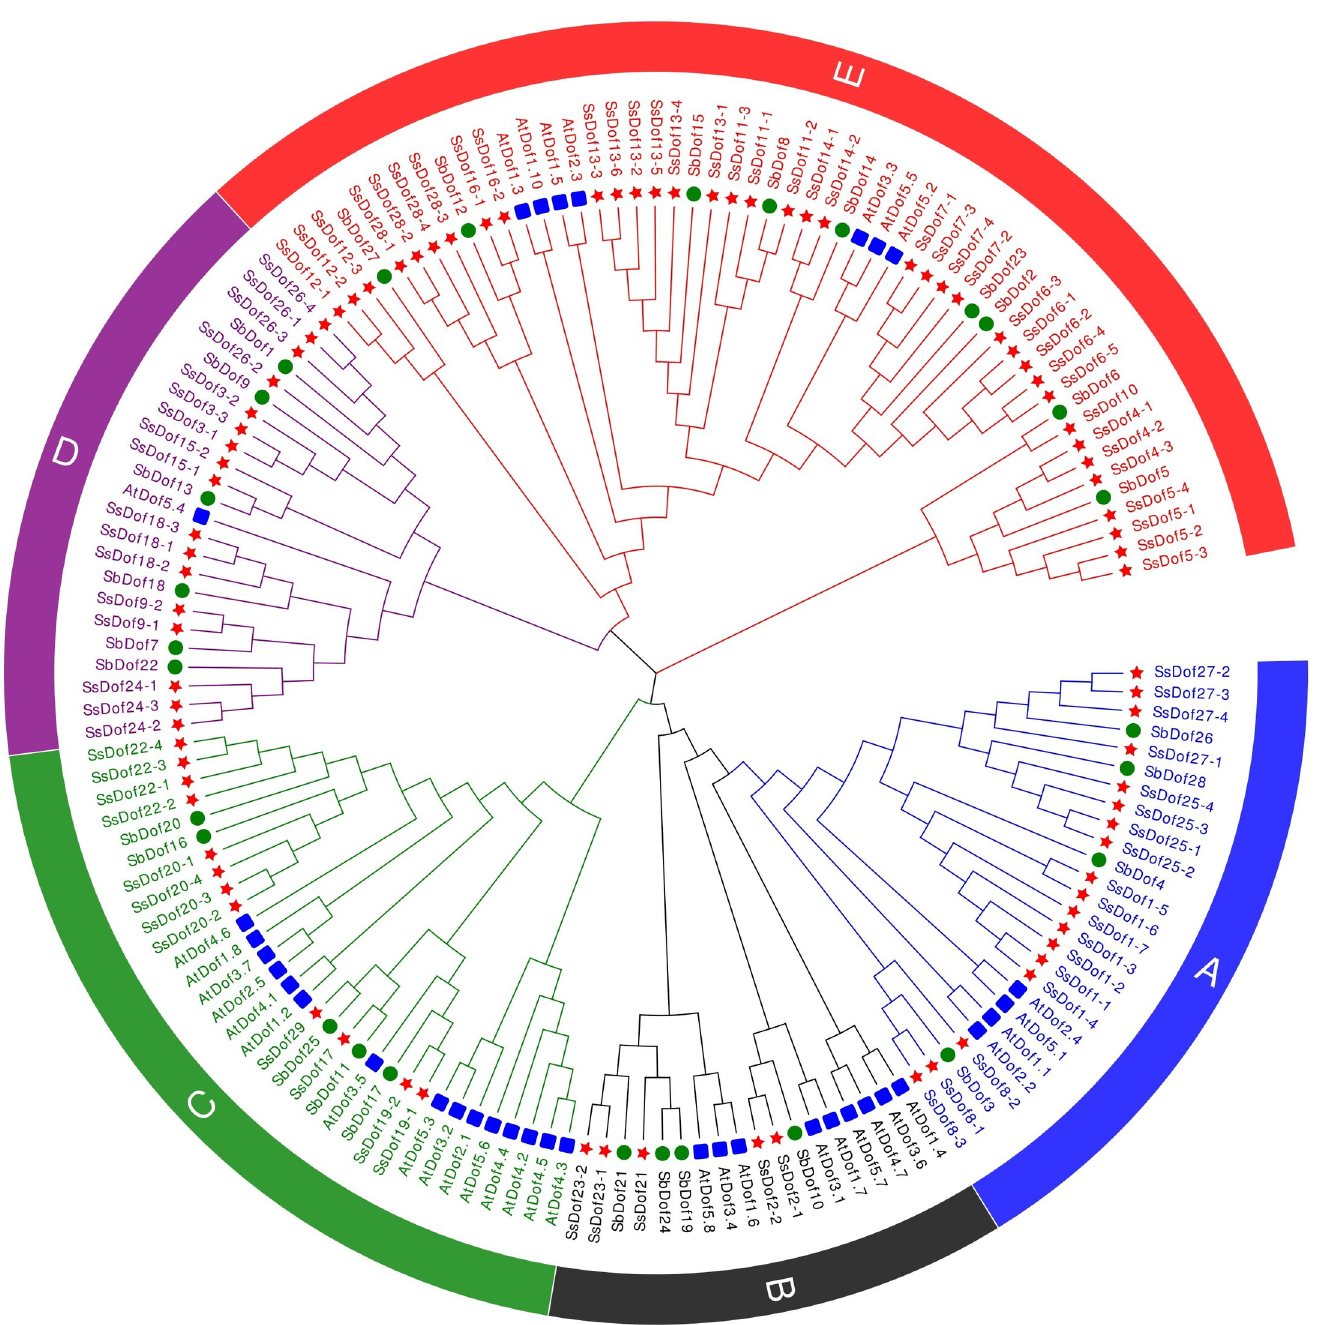
Fig 2. Phylogenetic relationships of Dof genes in sugarcane, sorghum and Arabidopsis. All Dof genes were divided into five groups (A, B, C, D and E) with different color arcs. The blue squares, green circles and red asterisks represent Dof genes from Arabidopsis, sorghum, and sugarcane, respectively.